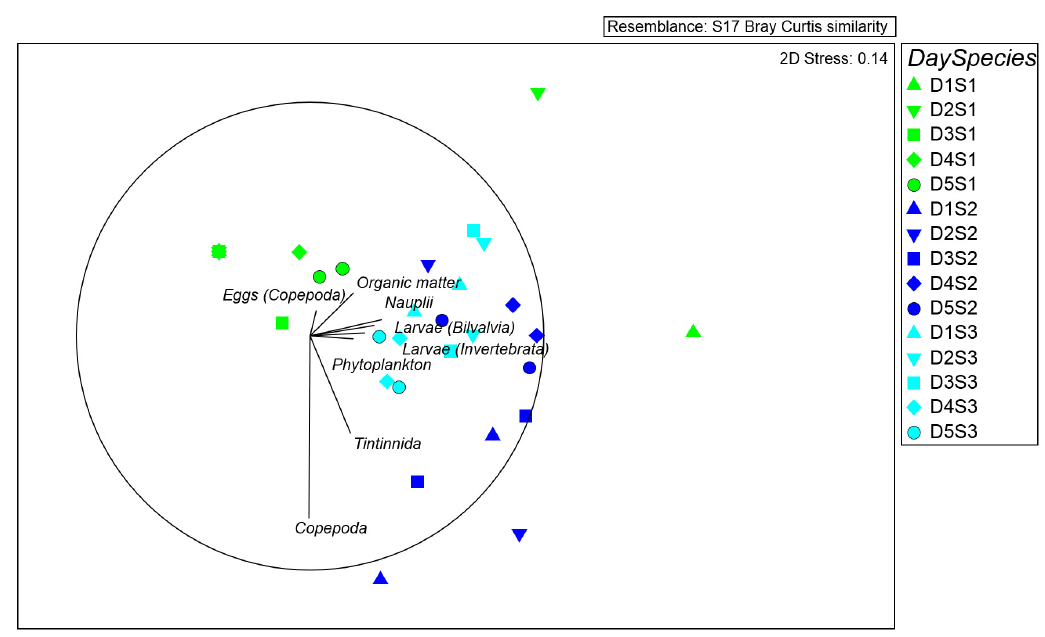
Figure 5. Multidimensional scaling (MDS) plot of the three investigated species based on sampling time centroids; vectors with Pearson’s correlation coefficients display prey abundance variables.